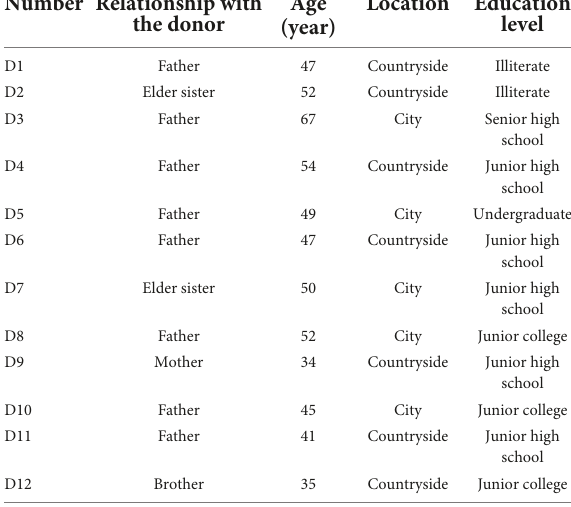
TABLE 2 General demographic data of the interviewees ( N =